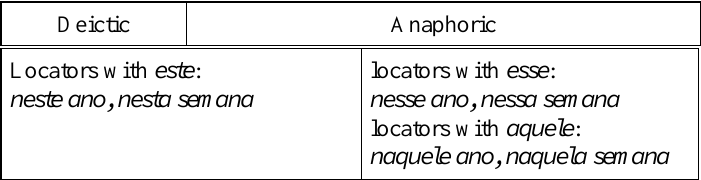
Table II – Referential dependencies of demonstrative locators in EP Deictic